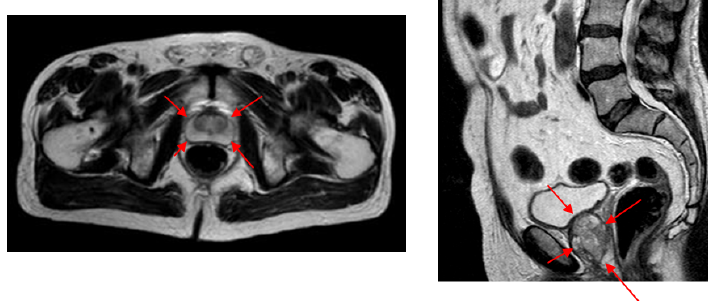
Figure 2. The prostate contours in transverse and sagittal MR images. Due to its high SNR values, MR is accepted as the gold standard in medical image-analysis studies of the